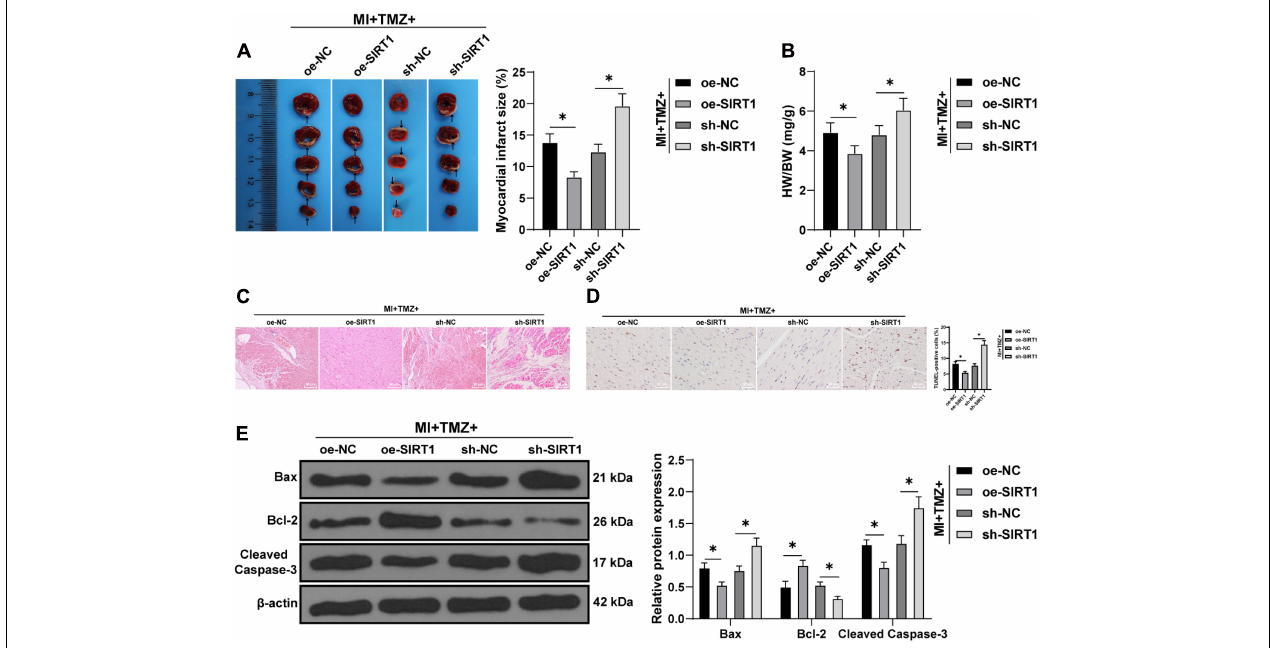
FIGURE 6 | Trimetazidine inhibited MI-induced apoptosis via the SIRT1–AMPK pathway in vivo . (A) MI was detected by TTC staining. Areas in white represent the MI region. (B) Heart weight was measured and the heart/weight ratio calculated. (C) Pathological changes of the myocardial tissue were detected by HE staining. (D) Myocardial apoptosis was detected by TUNEL staining. (E) Western blot analysis of Bax, Bcl-2, and cleaved caspase-3 ( N = 10 per group). All data were expressed as the mean ± standard deviation. Data were analyzed using one-way ANOVA, followed by Tukey’s multiple comparisons test. * P <